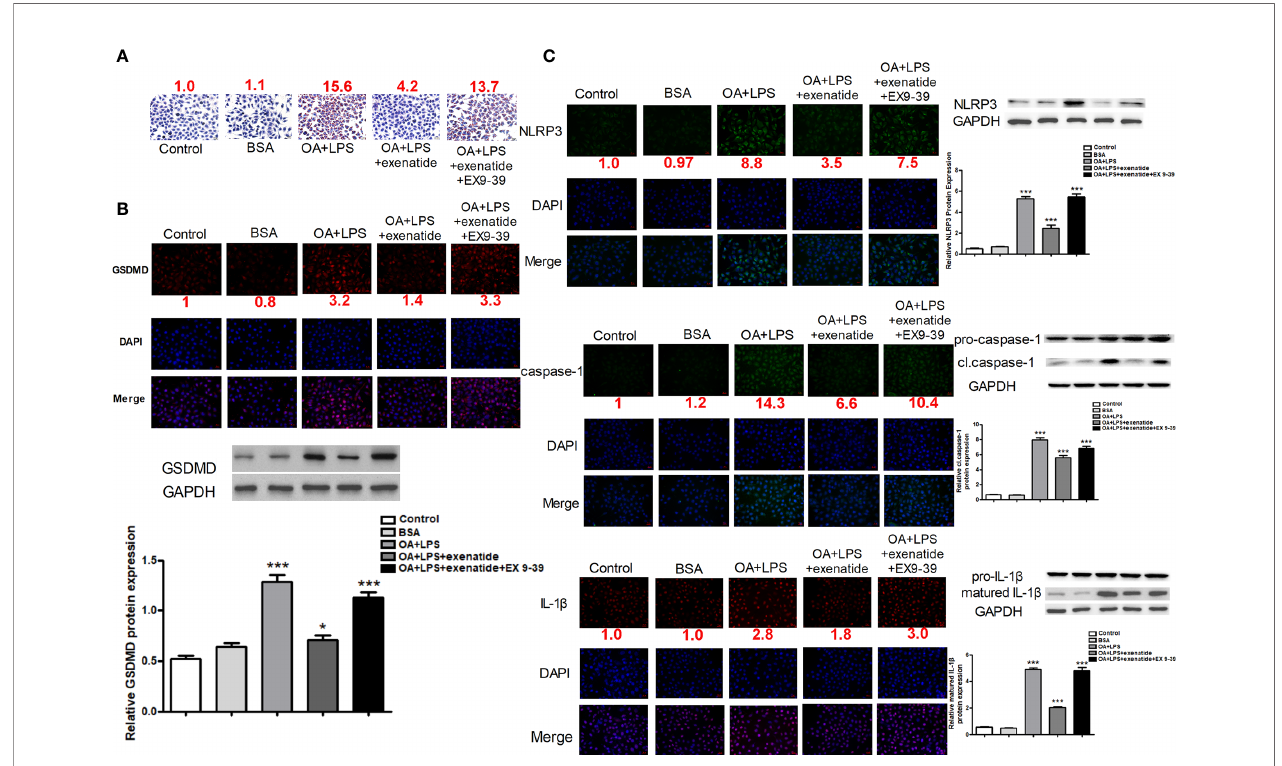
FIGURE 1 | Exenatide attenuated NASH by inhibiting the pyroptosis signaling pathway in vitro . (A) A representative Oil Red O staining image showed that exenatide attenuated NASH. The numbers above each picture (shown in red) indicated the relative staining intensity as quanti fi ed by ImageJ. (B) Representative immuno fl uorescence images of GSDMD and GSDMD protein expression levels measured by western blotting. (C) Representative immuno fl uorescence images of NLRP3, caspase-1, and IL-1 b . NLRP3, caspase-1, and IL-1 b . Protein expression levels were measured by western blotting. For panel (B, C) , the numbers below the images (shown in red) indicated the relative fl uorescence intensity as quanti fi ed by ImageJ. Two subcultures were used for each western blot markers and the experiment was repeated 2-3 times. *p < 0.1; ***p < 0.001. Data are expressed as the mean ±